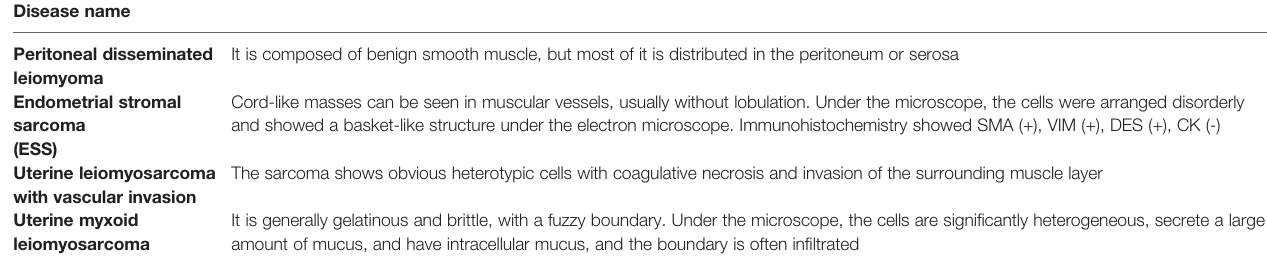
TABLE 3 | Pathological differential diagnosis.